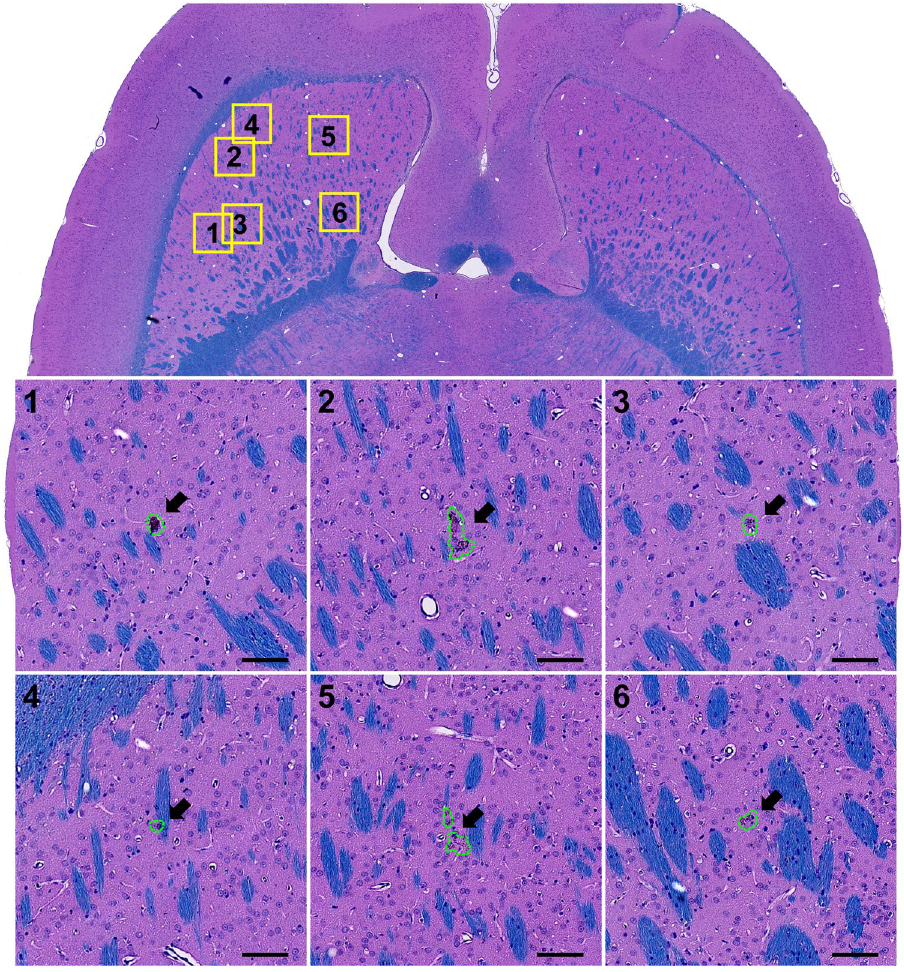
Figure 9. Microphotographs of a typical H&E-LFB stained section after three weekly sessions of FUS- induced BBB disruption and IN. Most of the brain appeared completely normal except for a few tiny clusters of hemosiderin particles. The segmentations used in measuring the dimensions and areas of these clusters are shown. Bars: 100 µ